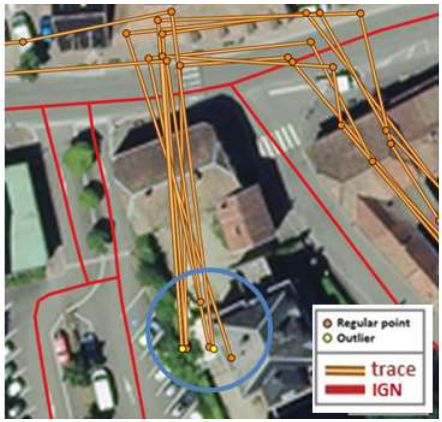
Figure 12. Example of false negative results.